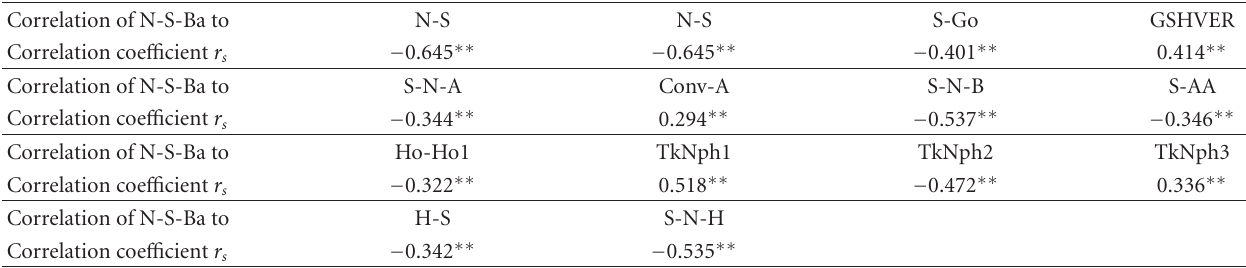
Table 4: Significant correlations found between skull base flexion and other cephalometric variables.